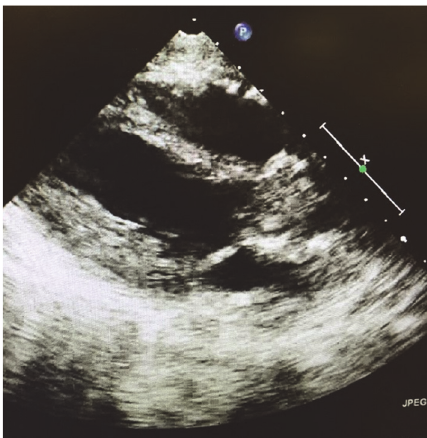
Figure 5: Repeat echocardiogram showing larger left ventricle with markedly reduced function, as well as mitigation of previously overloaded right ventricular size and function.